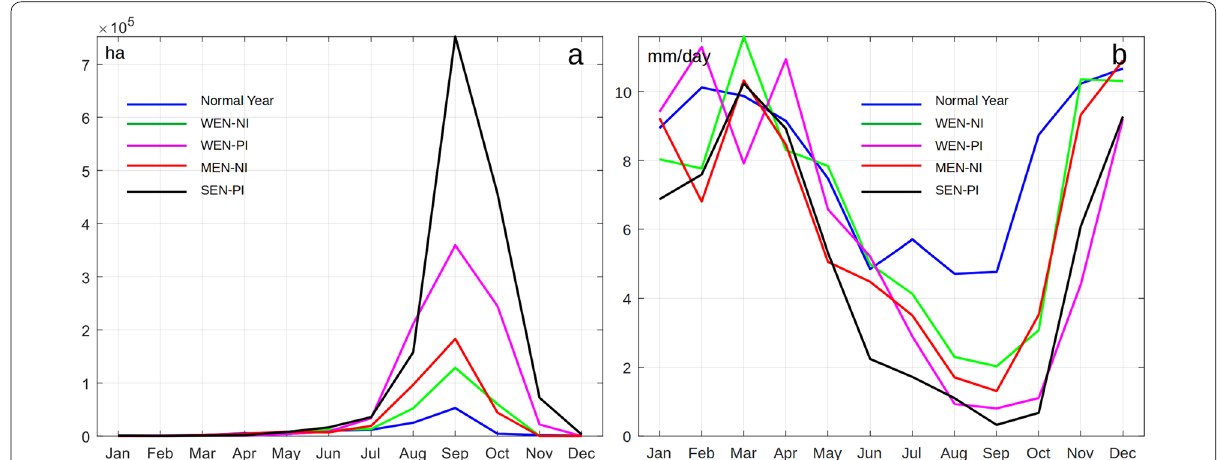
Fig. 7 Temporal of joint pattern for each category on South Sumatra. Burned area graph ( a ) represents the average total burned area of the composite year. In contrast, the precipitation graph ( b ) represents the average monthly average precipitation from each grid of composite year for each